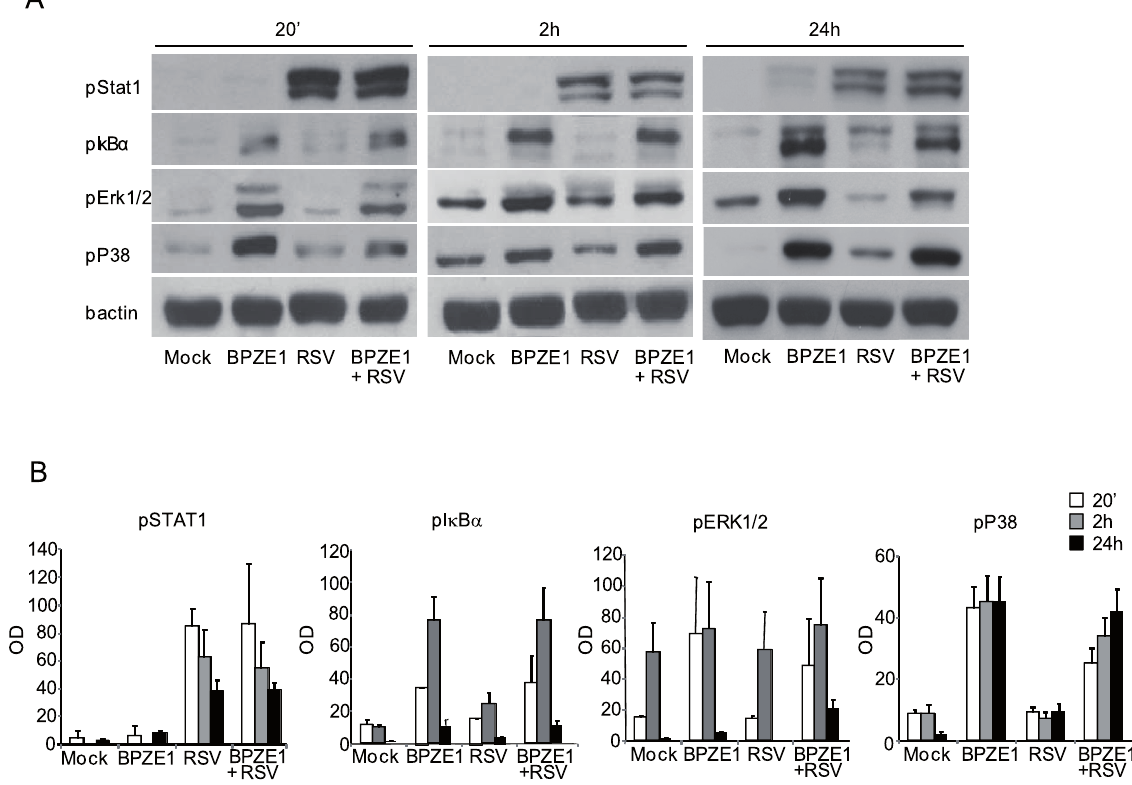
Figure 5. RSV- and BPZE1-induced signaling pathways in MDDC. A : Total cell lysates were prepared from MDDC treated with BPZE1 (100:1), RSV (MOI of 1) or both at the indicated time-points. Mock-infected cells were added as control. Proteins were resolved by 10% SDS-PAGE and Western blot analysis was performed to detect the phosphorylation of STAT1, IkB a , ERK1/2 and p38. Human phosphorylated b actin was used to normalize the results. Data are from one representative of three independent experiments performed with MDDC obtained from different donors. B : Histograms represent means of the relative optical density of phosphorylated proteins from three independent experiments. Error bars represent SEM.